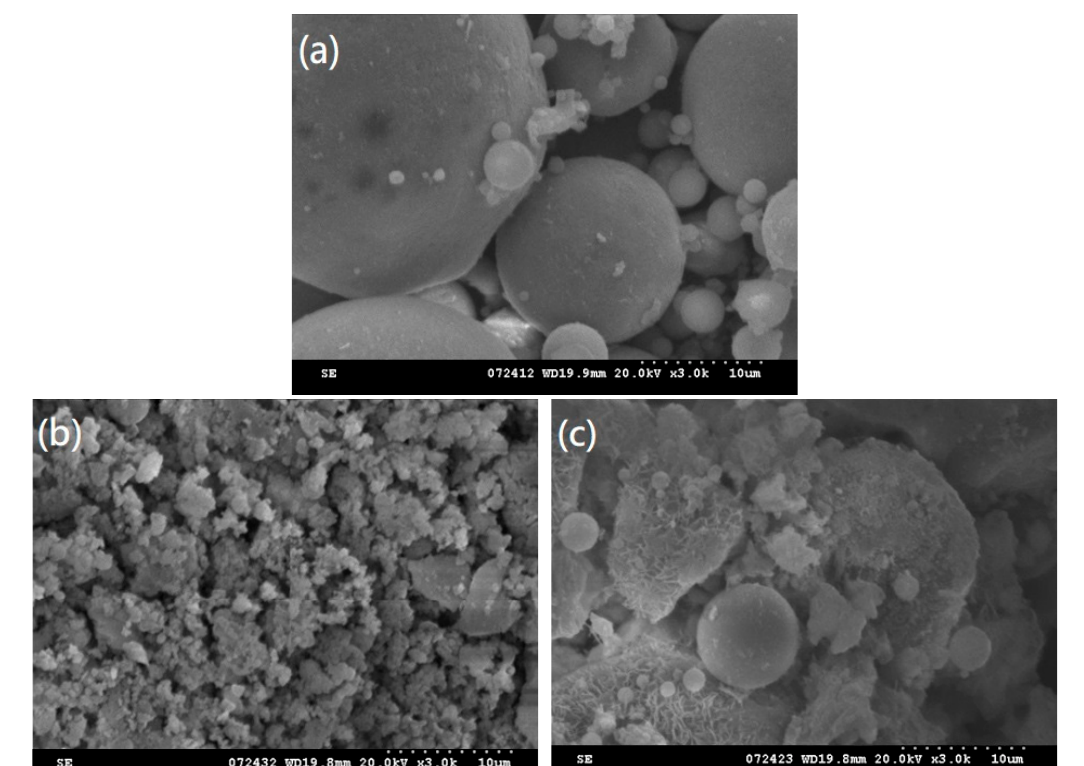
Figure 3. TGA and DTG heating curves of ( a ) PCFA, ( b ) PPMS-CCFA, ( c ) PR-CCFA.